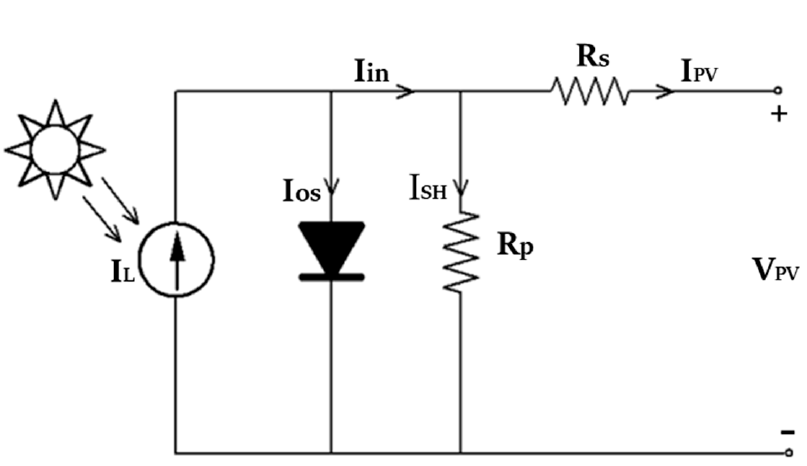
Figure 2. An equivalent circuit of a solar